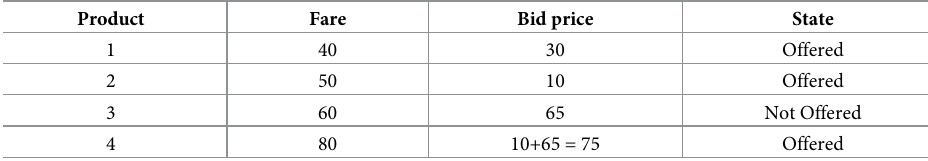
Table 5. State of the products in the example network.